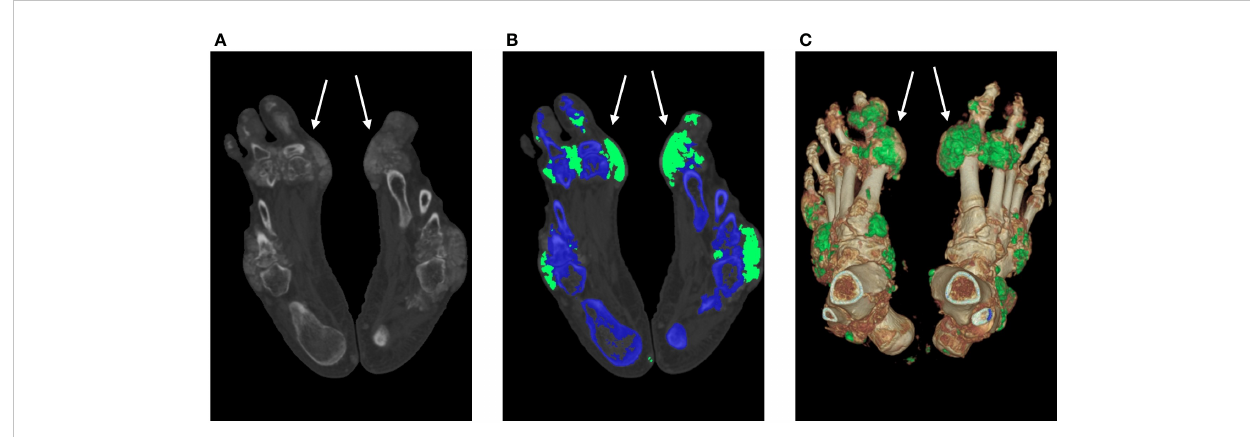
FIGURE 4 MSU crystal deposition and bone erosion. An MSU crystal was discovered in a 53-year-old man despite modest blood uric acid levels (323 m mol/L). The DECT images illustrate the MSU deposition of the feet (white arrow). A 140-kV CT image showing hyperdense deposition (left); color-coded 50% mixed-energy CT image (middle) showing MSU crystal (green) and bone structure (blue); and surface-rendered three-dimensional CT image (right) showing MSU crystal (green) and bone structure (white). The erosion score is 8 in the left MTP1 joint and 10 in the right MTP1 joint. CT, computed tomography; DECT, dual-energy computed tomography; MSU, monosodium urate; and MTP, metatarsophalangeal